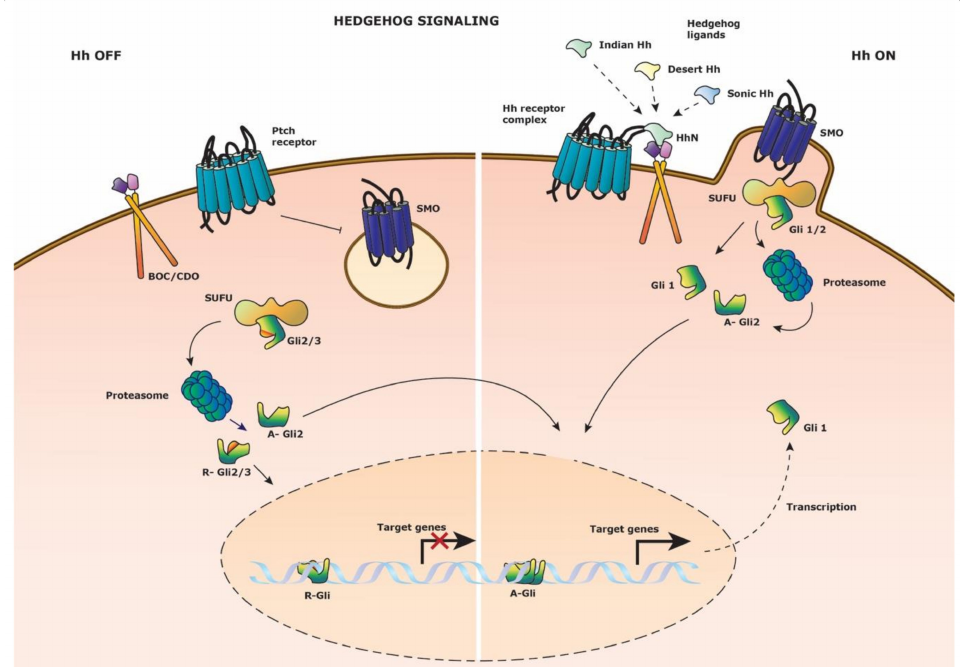
Figure 4. Hedgehog signaling pathway. Schematic representation of the Hedgehog signaling pathway. (Left side) Hedgehog signaling is inactive in the absence of Hedgehog ligand on the Patched (Ptch) receptor. Smoothened (SMO) is restrained from cell membrane anchoring. Suppressor of fused (SUFU) direct the proteasomal cleavage of transcription factors Gli1 and Gli3 to their repressor form; R-Gli2 and R-Gli3. These transcriptional repressors translocate to the nucleus to block target gene expression. (Right side) Hedgehog signaling is activated upon binding of either three of the N-terminal domains (HhN) of the Hedgehog ligands to the Hedgehog (Hh) receptor complex composed out of Ptch and co-receptor BOC / CDO. SMO fuses with the cell membrane and binds SUFU with the bound Gli2 transcription factor. Gli2 is released and undergoes proteasomal degradation to it activator A-Gli2 form which translocates to the nucleus to drive target gene expression. Gli1 is transcribed and reinforces the Hedgehog signaling as a transcriptional